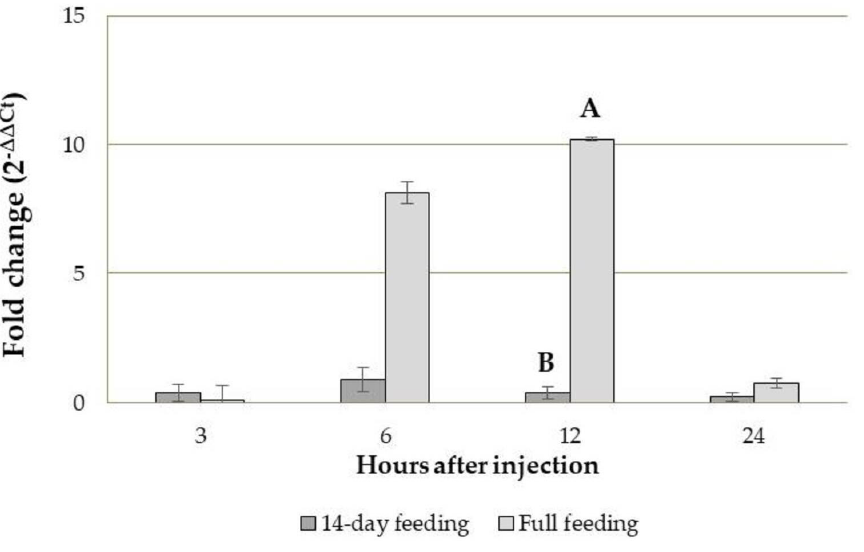
Figure 5. Gene expression (2 ‒∆∆Ct ) of Tenecin 3 after 3, 6, 12 and 24 h from B. bassiana injection in T. molitor larvae reared on +GRAIN for a 14-day feeding period or diet since their eclosion (full feeding). Values are reported as average fold change variation (mean ± SE). For each time point, samples were normalized against larvae injected with B. bassiana and reared on BRAN for a 14-day feeding period or since their eclosion (full feeding), respectively. Different letters indicate significantly different values (Student’s t -test, p < 0.05).